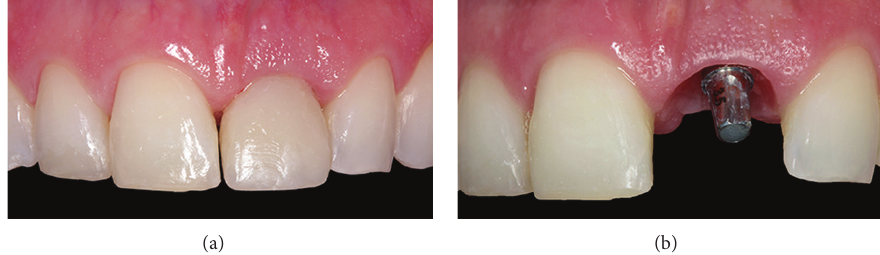
Figure 9: Images showing the provisional crown, restoring the maxillary right central incisor and gingival tissue after four months.